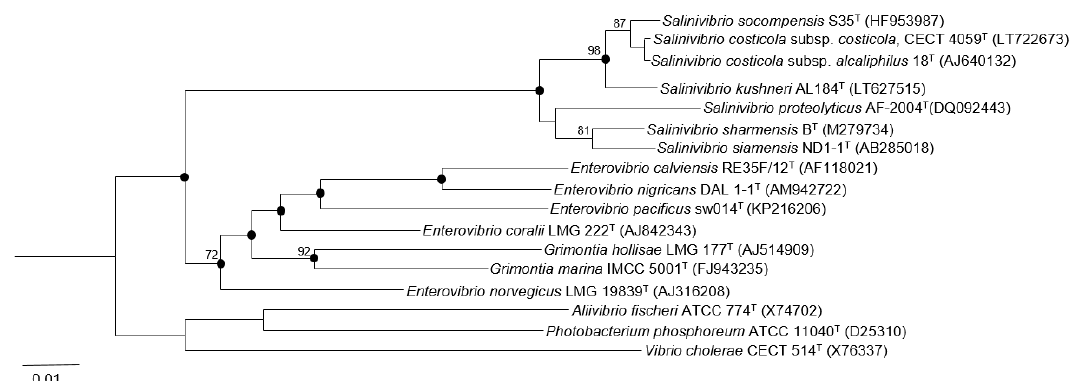
Figure 1. Neighbor-joining phylogenetic tree based on the 16S rRNA gene sequence comparison, showing the relationships between strain S35 T and other members of the genus Salinivibrio and the family Vibrionaceae . Filled circles indicate nodes that were also obtained in trees based on maximum parsimony and maximum likelihood algorithms. Bootstrap values over 70% are shown at the nodes. The accession numbers are shown in parenthesis. Bar, 0.01 substitutions per nucleotide position.